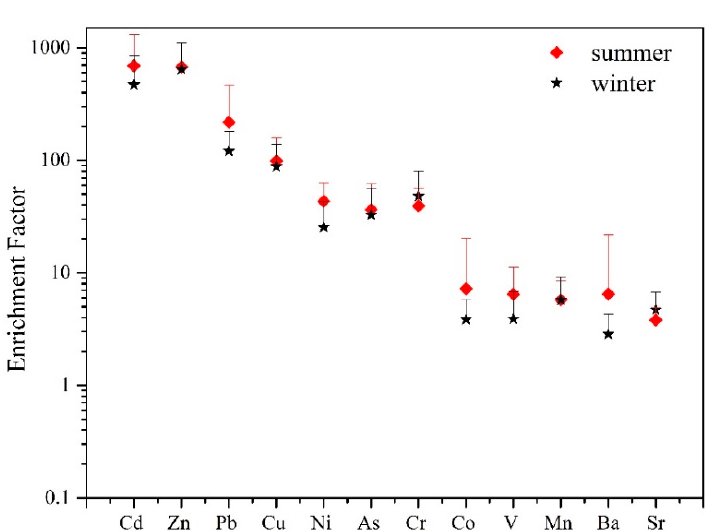
Figure 2. Enrichment factors of heavy metals in PM 2.5 in summer and winter 2016 (Nanjing). Table 1. Average mass concentrations (ng/m 3 ) and mass fractions ( μ g/g) of heavy metals in PM 2.5 in summer and winter.